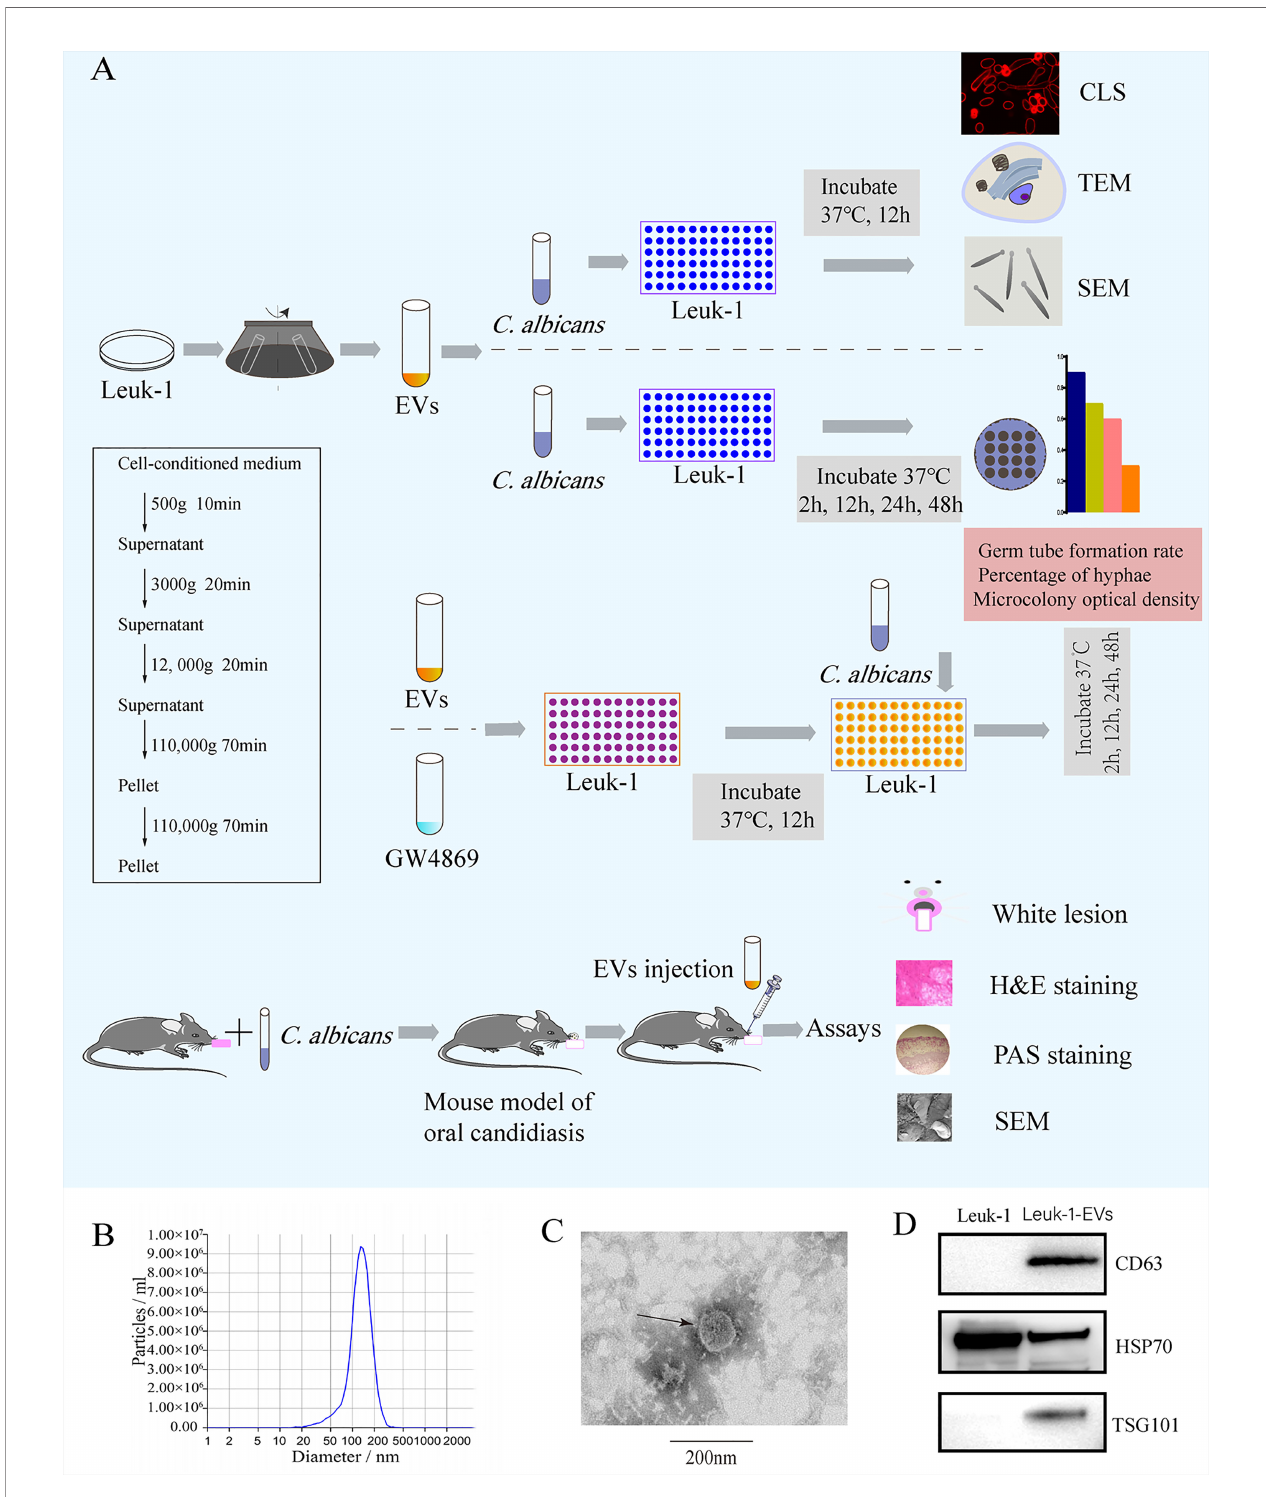
FIGURE 1 | Flow chart of the experiment and characterization of EVs derived from Leuk-1 cells. (A) Centrifugation protocol for EVs and study fl ow. (B) Size analysis of Leuk-1-EVs using tunable resistive pulse sensing (TRPS)-based analysis (qNano). (C) Transmission electron microscopy image of EVs. Scale bar, 200 nm. (D) Western blotting analysis of the EVs obtained using ultracentrifugation of Leuk-1 cell supernatants. The positive controls were Leuk-1 cells. EVs, extracellular vesicles. CLS, confocal laser scanning. TEM, transmission electron microscopy. SEM, scanning electron microscopy. H&E, hematoxylin and eosin. PAS, periodic